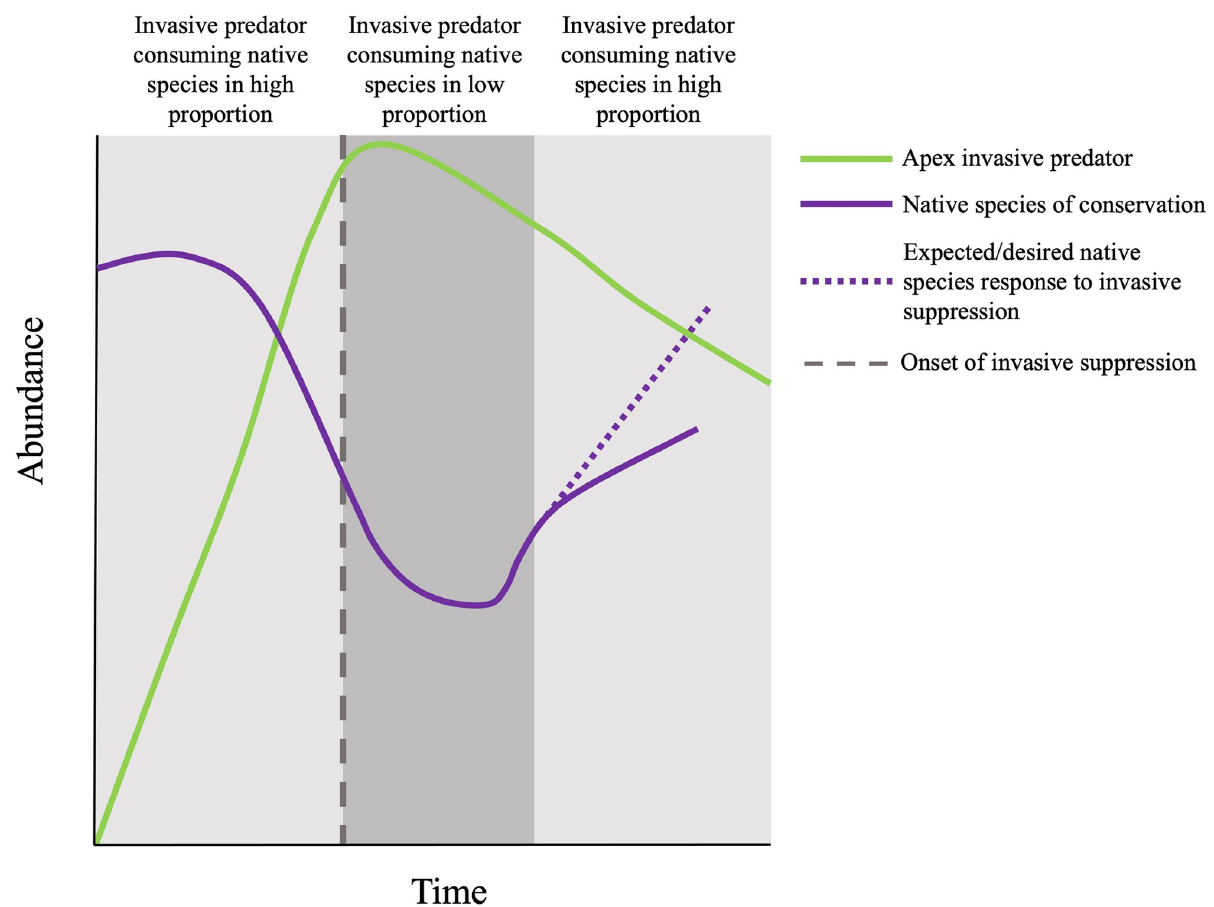
Fig 9. Conceptual model representing dynamics of an apex invasive predator undergoing suppression and a native species of conservation responding to the diet plasticity of the invasive species. Solid lines represent abundances over time from the start of invasive species expansion to the most recent time of suppression. Grey hues represent the diet plasticity of the invasive predator. Light grey polygons represent periods in which the invasive predator consumed their preferred prey, the native species of conservation, in high diet proportion. The dark grey polygon represents a period in which the invasive predator consumed a less-preferred prey in high diet